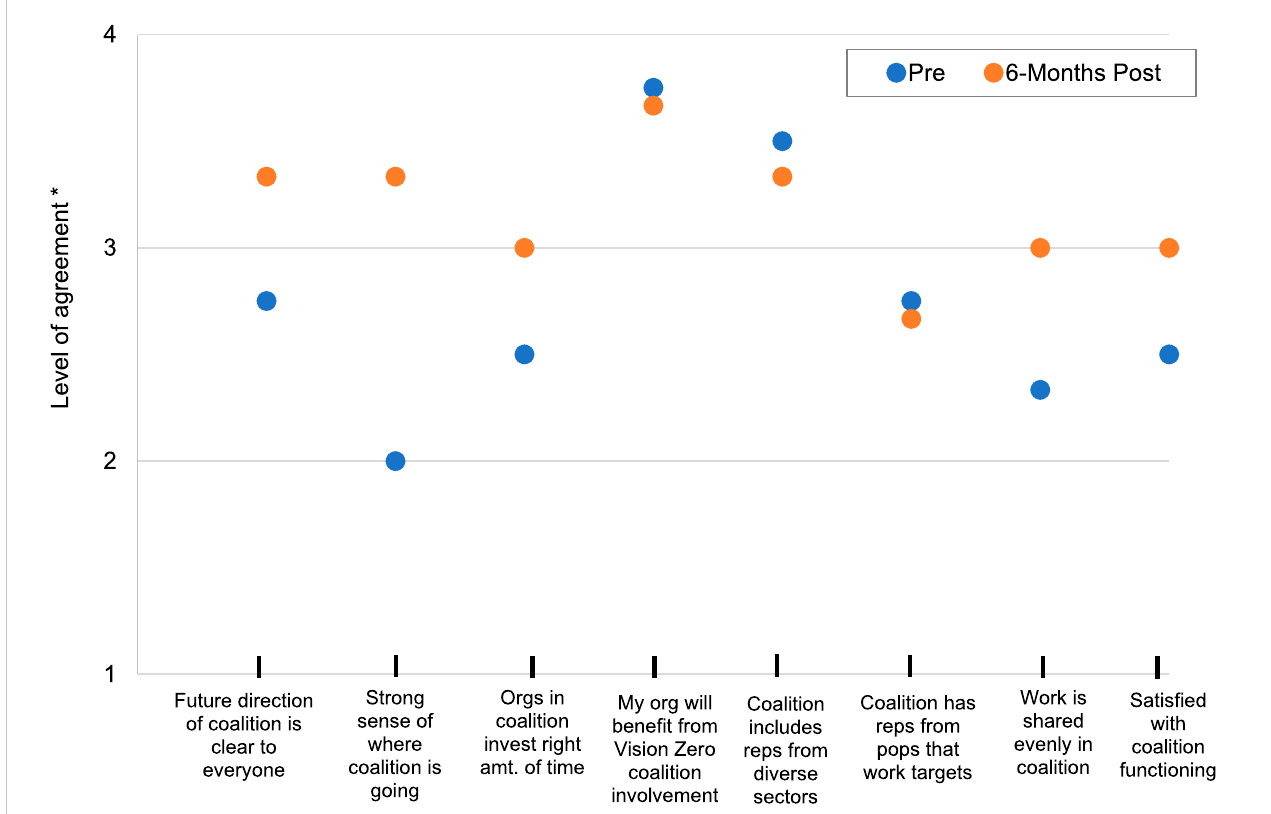
FIGURE 4 Team-speci fi c change in perceived coalition commitment, diversity, and functioning between Vision Zero Leadership Institute and 6-month post- assessment.